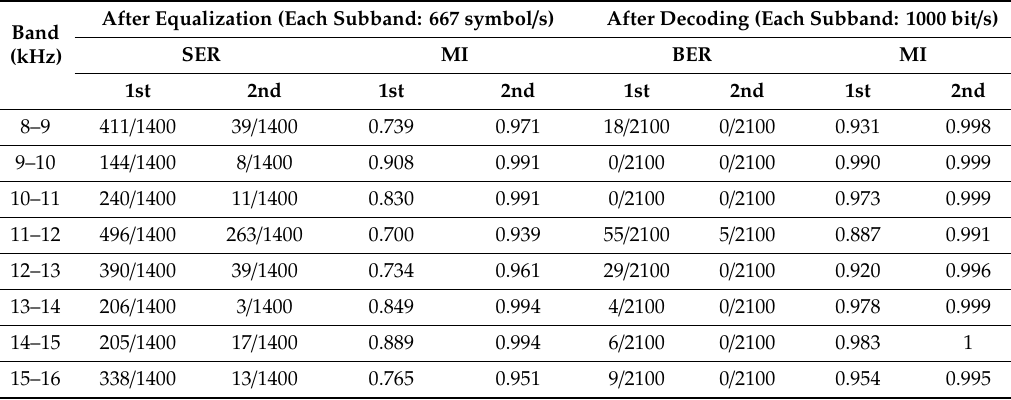
Table 2. Results of the proposed method with BPSK mapping. Table 3. Results of the proposed method with 8PSK